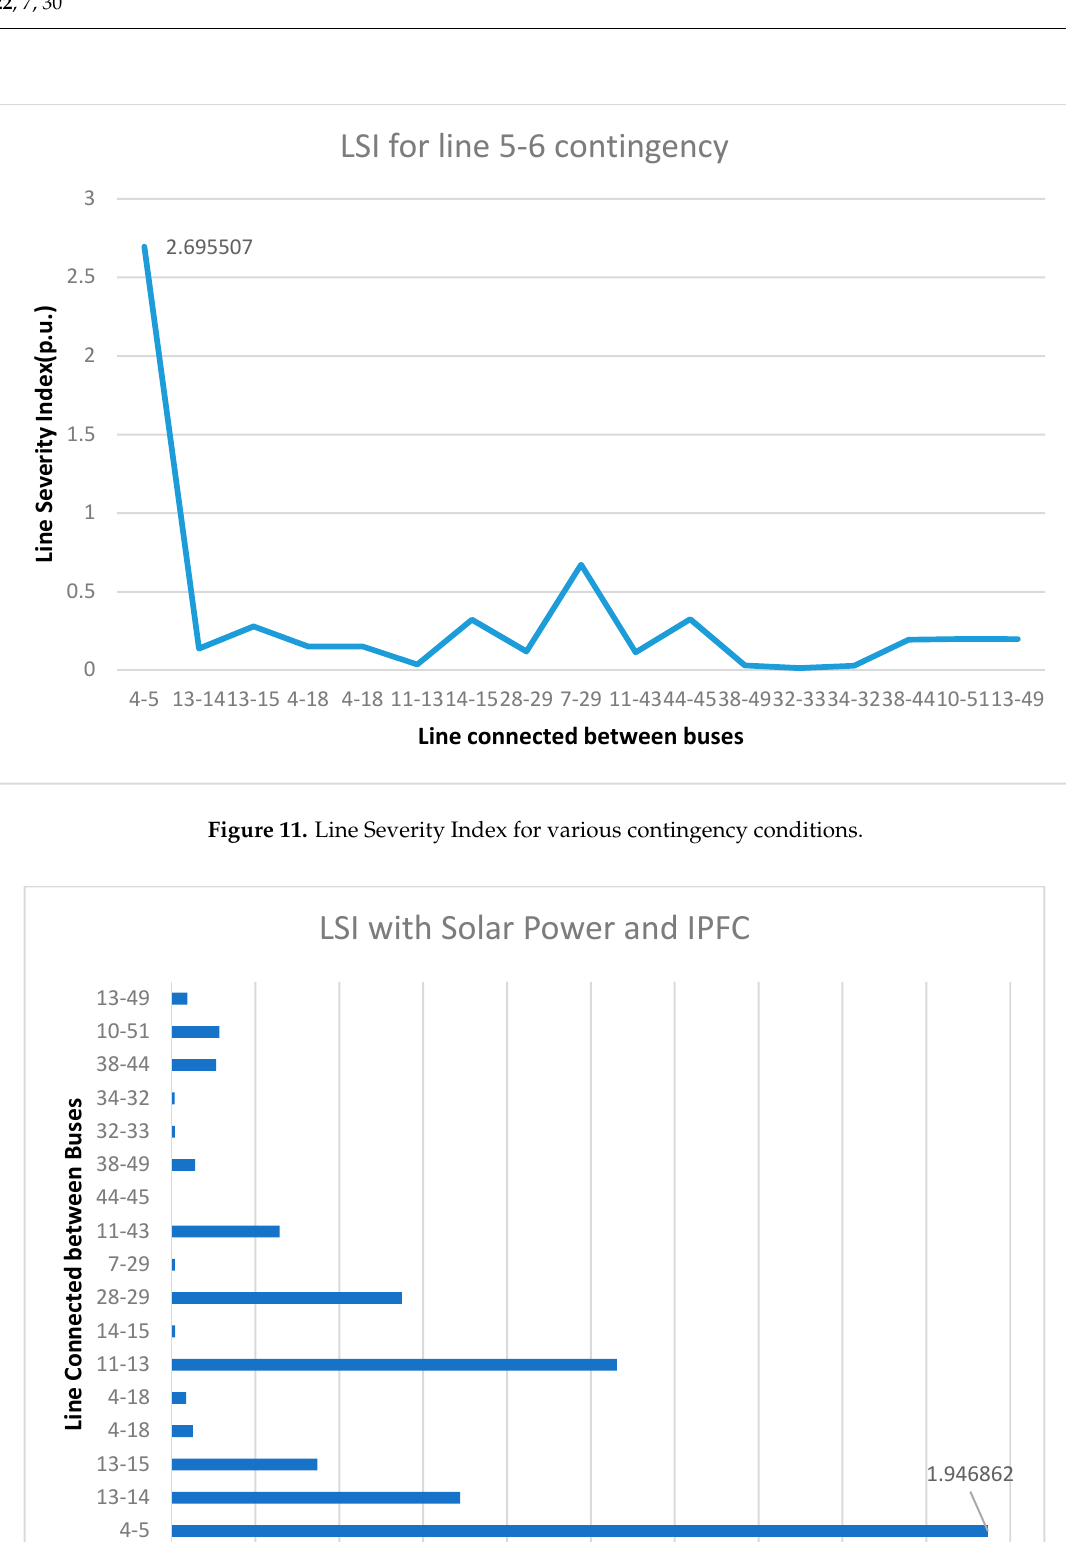
Line Severity Index (p.u.) Line Severity Index (p.u.) Figure 12. Line Severity Index of the IEEE 57 Bus system with IPFC and Solar Power Unit. Figure 12. Line Severity Index of the IEEE 57 Bus system with IPFC and Solar Power Unit. Figure 12. Line Severity Index of the IEEE 57 Bus system with IPFC and Solar Power